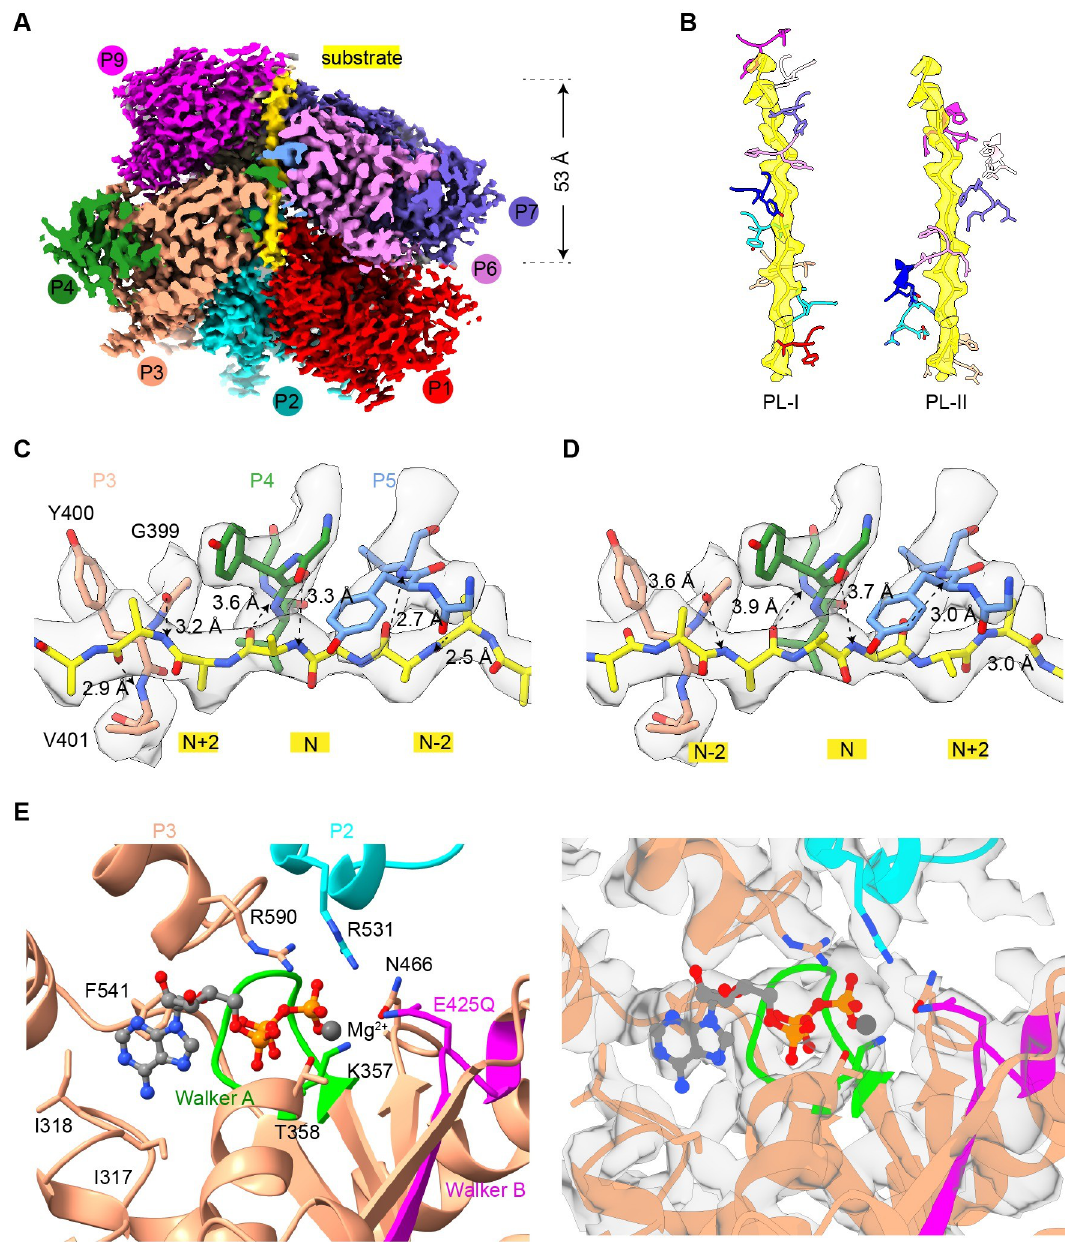
Fig 5. Structure of the NBD nonamer in processing a peptide substrate. ( A ) Density map of the NBD nonamer in the substrate- processing state. Nine protomers are indicated as P1 to P9 and painted in different colors. The central substrate is colored yellow. ( B ) The spiral configuration of the PLs of CLPB protomers around the substrate in the central channel. PL-Is and PL-IIs are shown in the left and right panels, respectively. While the conserved PL-Is (G399-Y400-V401-G402) directly interact with the substrate, the PL-IIs (E386-R387-H388) situate in slightly larger distances from the substrate. ( C, D ) Magnified view of the interactions between the PL-I of P3, P4, and P5 and the backbone of substrate. The substrate could be modeled in both directions, N to C or C to N. The potential hydrogen bonds are indicated by dashed lines and the distances are labeled. ( E ) Magnified view of the conserved ATP-binding pocket of CLPB. Functionally important residues of Walker A motif (K357, T358), Walker B motif (E425), sensor-1 (N466), sensor-2 (R590), arginine finger (R531), and the conserved residue I317, I318. Atomic model and density map are shown in the left and right panels, respectively. NBD, nucleotide-binding domain; PL, pore-loop.